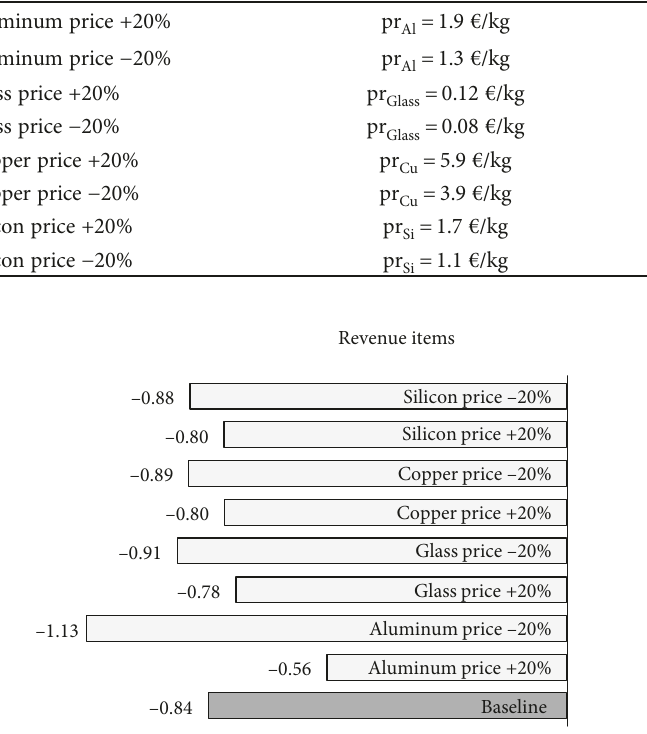
Figure 2: NPV/size ( € /kg) in alternative